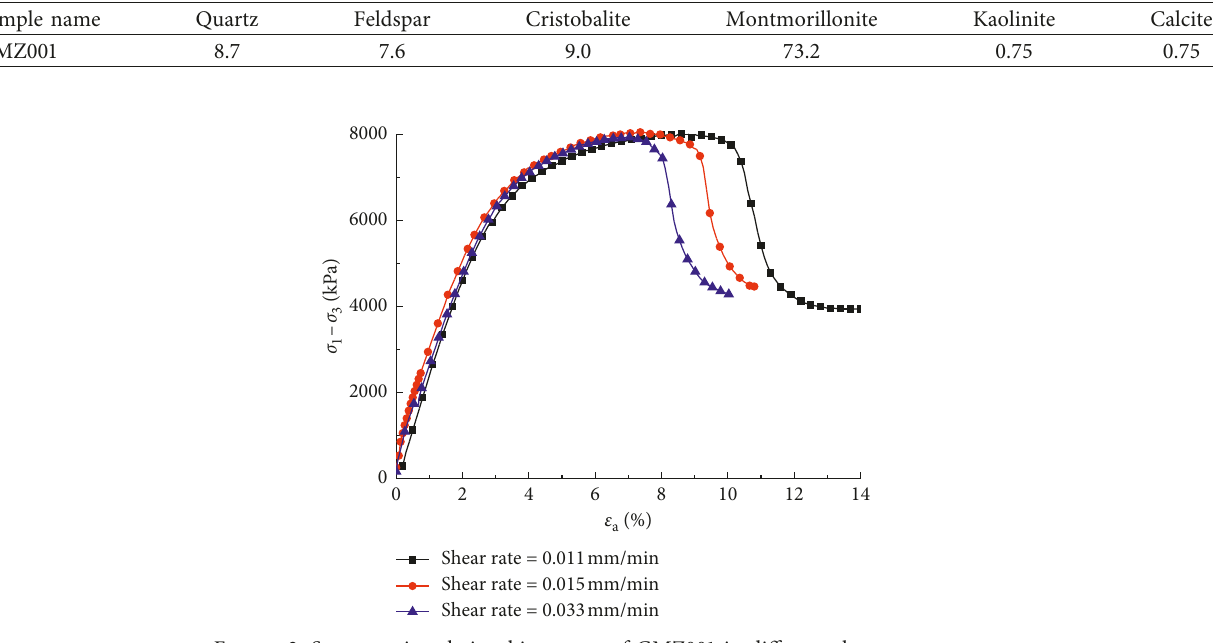
Figure 2: Stress-strain relationship curves of GMZ001 in different shear rate tests.